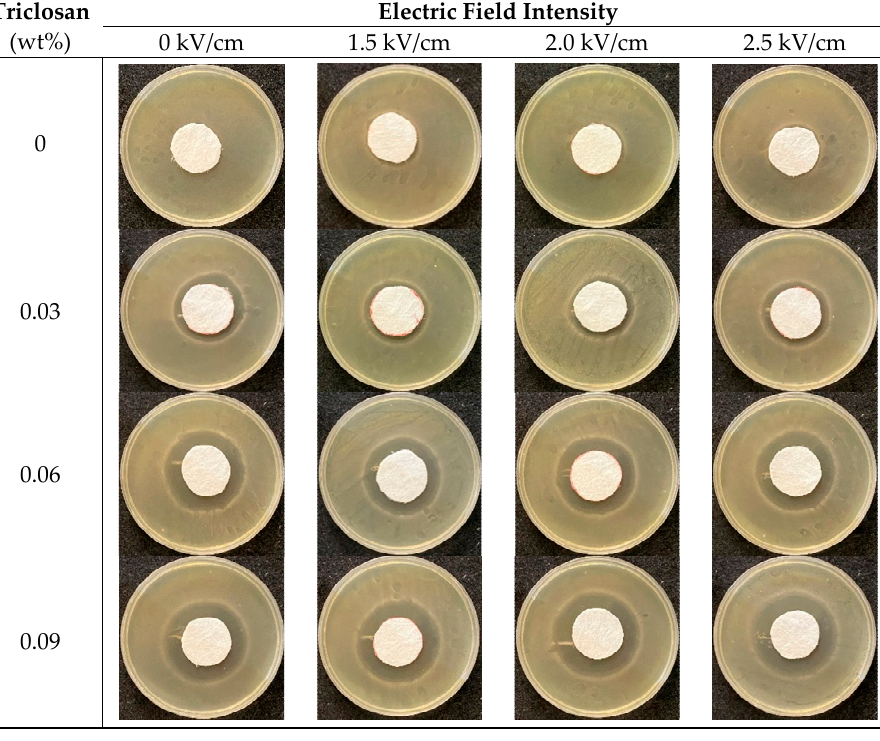
Figure 4. Inhibition zone against S. aureus as related to triclosan amount (rows 1–4: 0, 0.03, 0.06, and 0.09 wt%) and electric field intensity (columns 1–3: 1.5, 2.0, and 2.5 kV/cm). Table 2. Effects of triclosan amount (0, 0.03, 0.06, and 0.09 wt%) and electric field intensity (1.5, 2.0, and 2.5 kV/cm) on inhibition zone against E. coli and S. aureus .